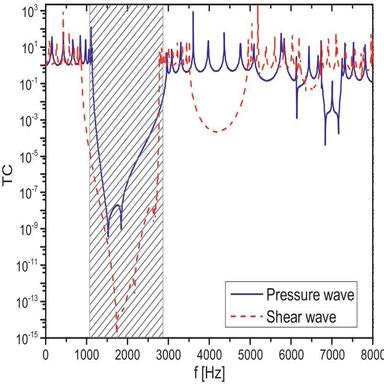
Transmission coefficient of the melamine-aluminum in the finite media. The shaded area corresponds to the band gap obtained from the dispersion analysis.